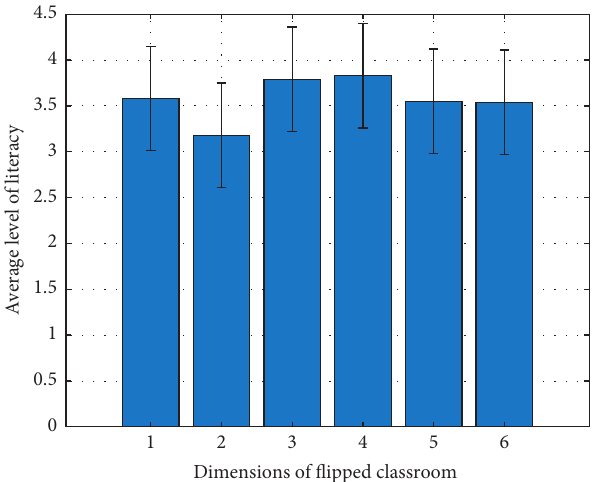
Figure 6: Digital citizenship literacy of college students and its current situation in various dimensions.